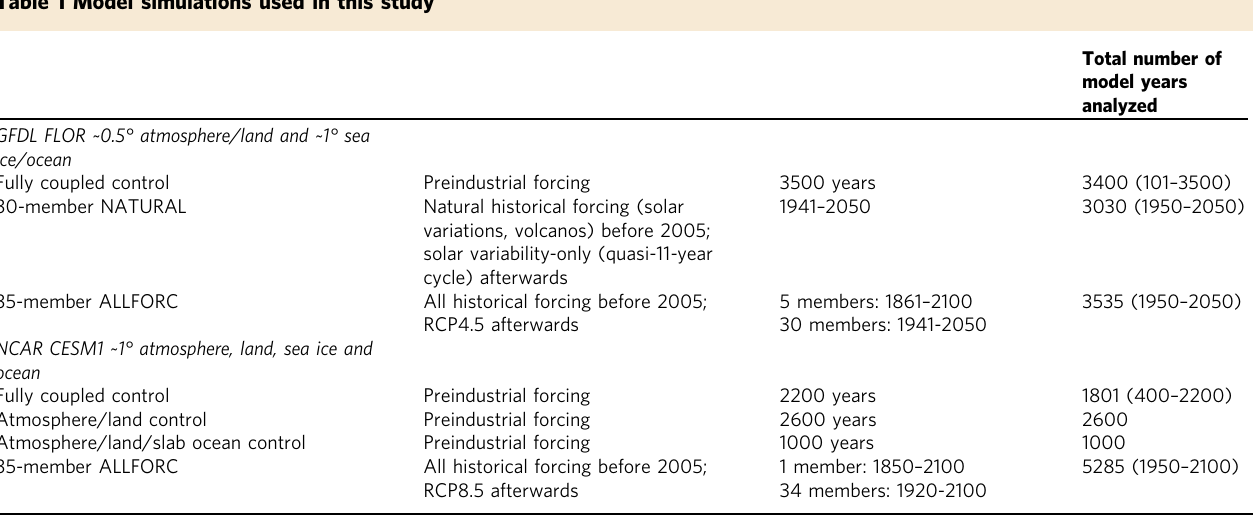
Table 1 Model simulations used in this